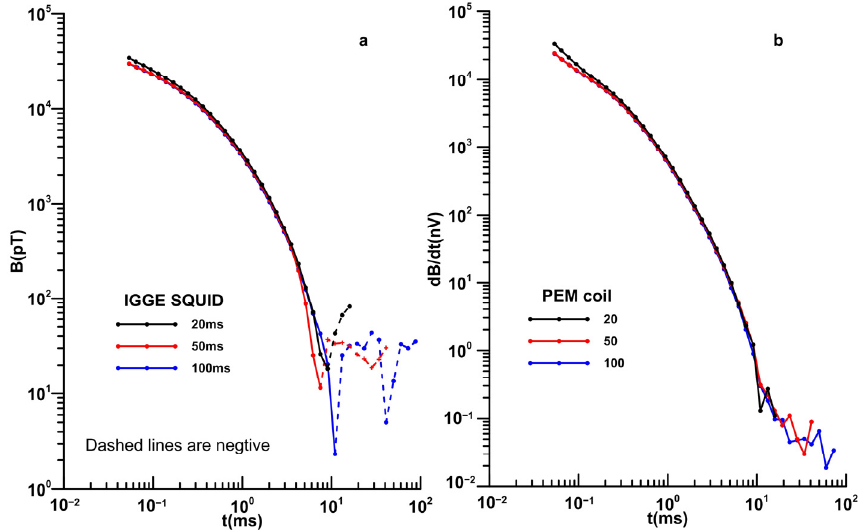
Figure 9. Comparison of SQUID and coil decay curves with different time base. ( a ) TEM decay curves of IGGE SQUID data; ( b ) TEM decay curves of PEM coil data.